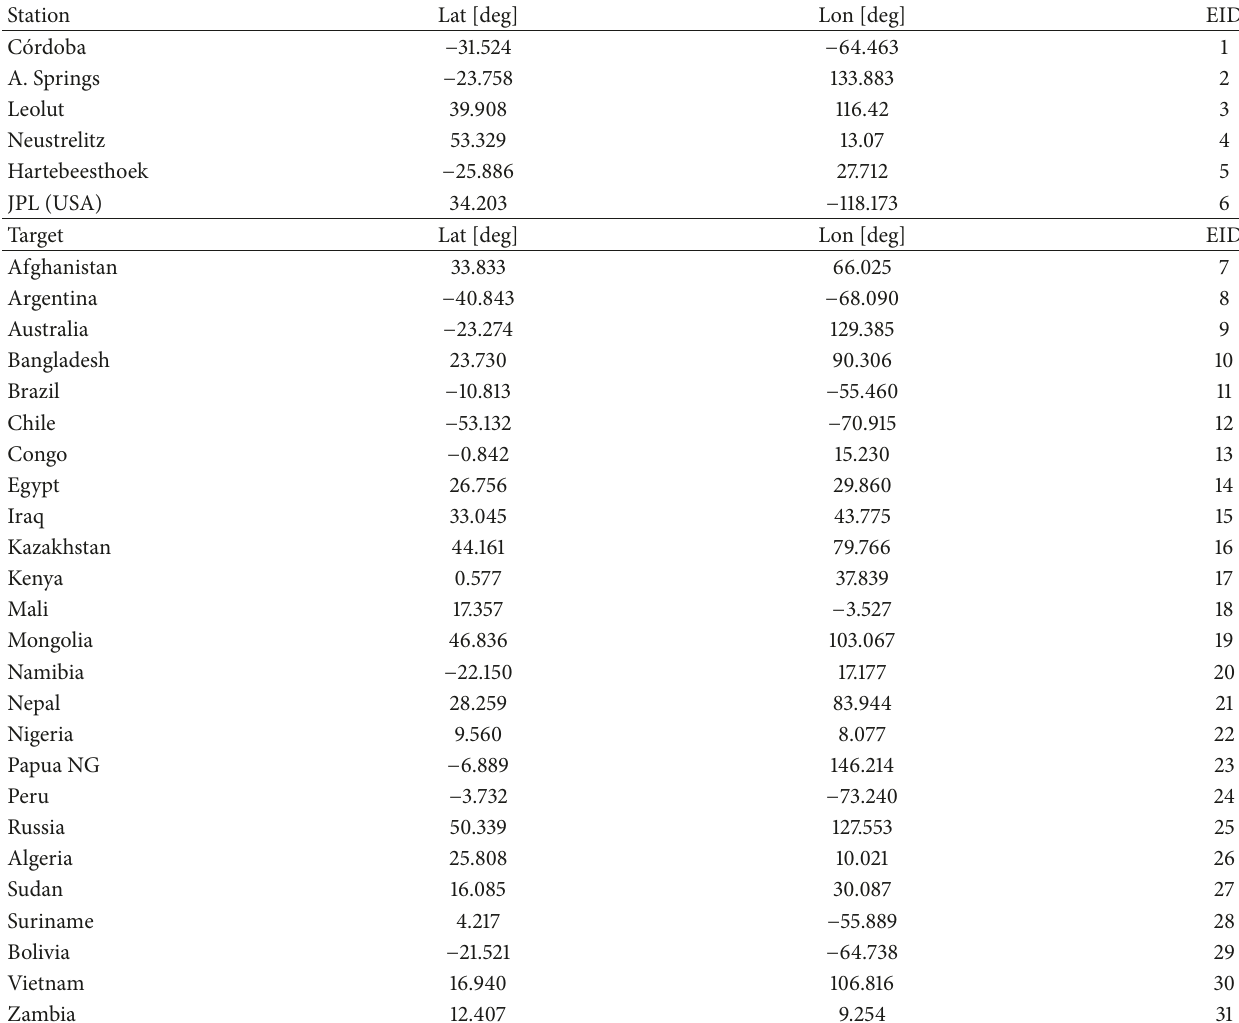
Table 4: Ground station and ground target